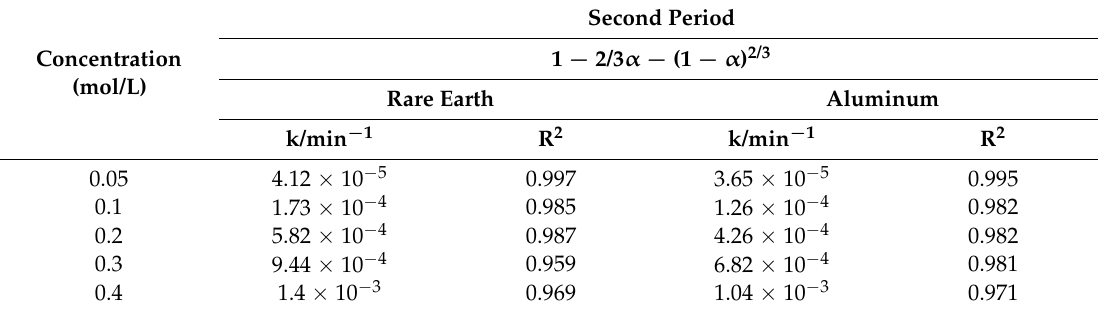
Table 5. Apparent rate constant (k) and correlation coefficients values (R 2 ) of rare earth and aluminum at different